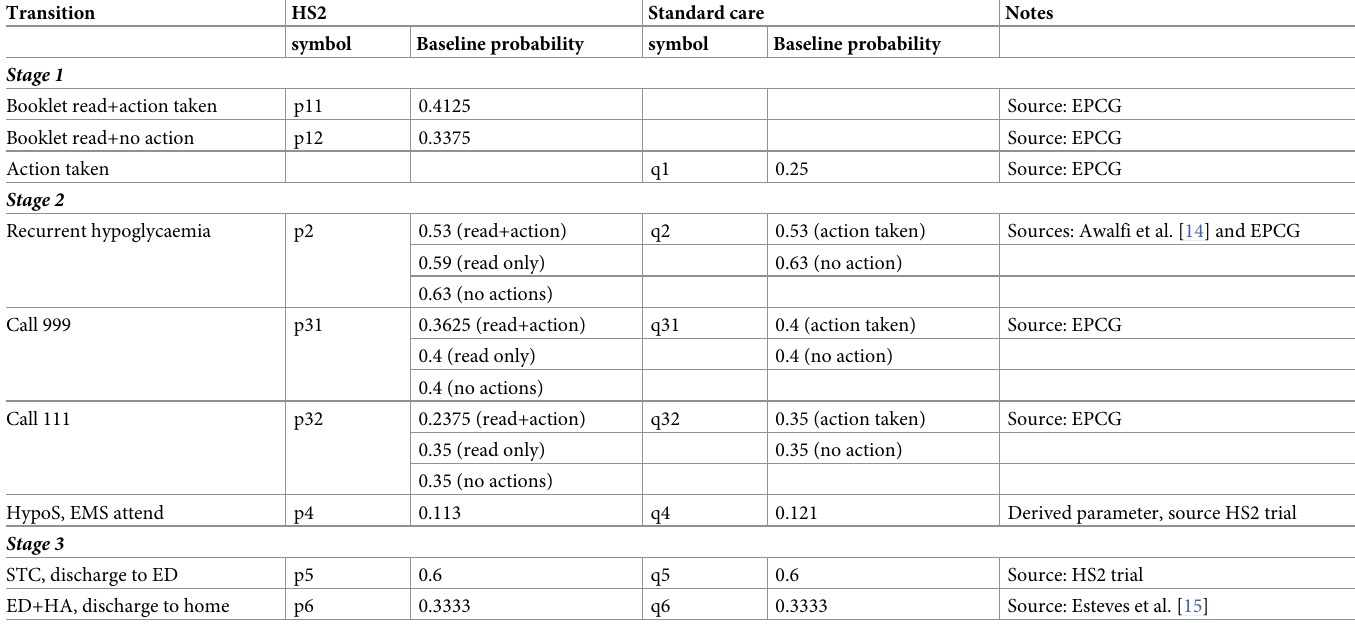
Table 3. Model transition